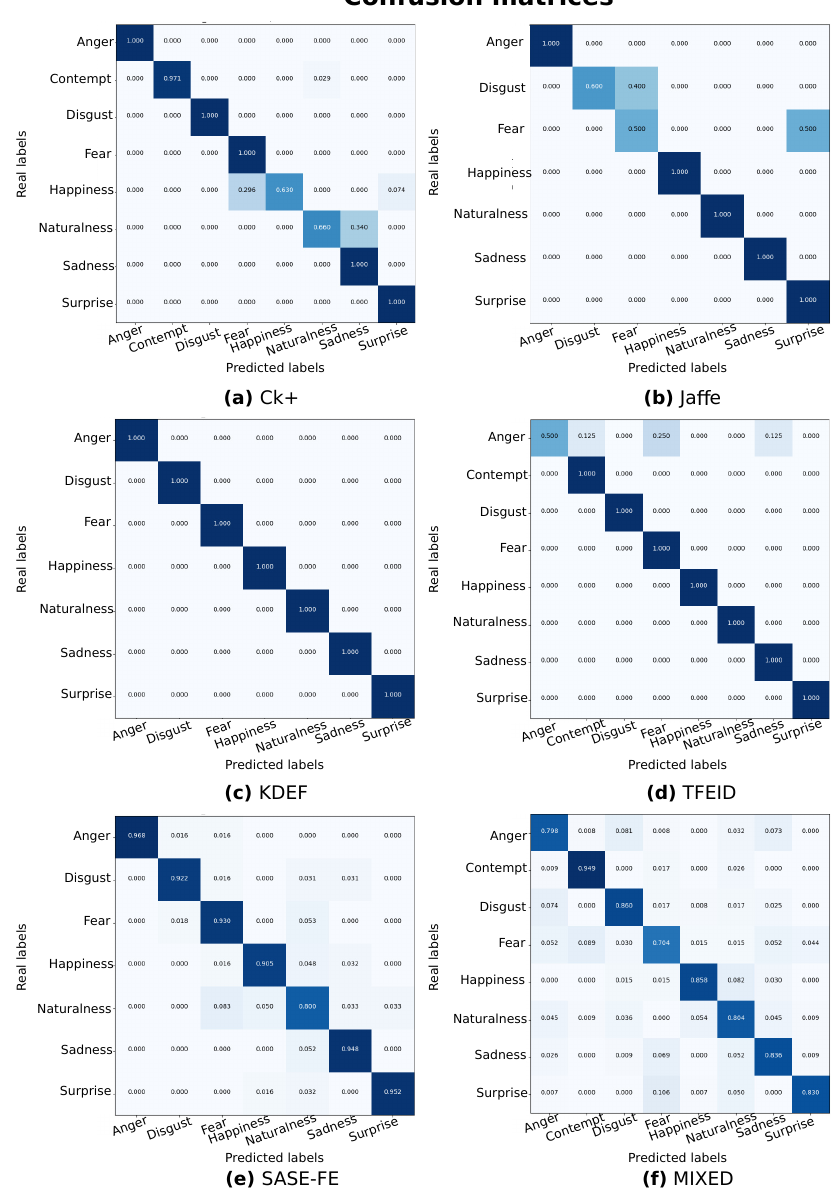
Figure 8. Confusion matrices over the examined datasets. The shades of colors indicate the classifica- tion performance. Darker colors are associated with higher prediction